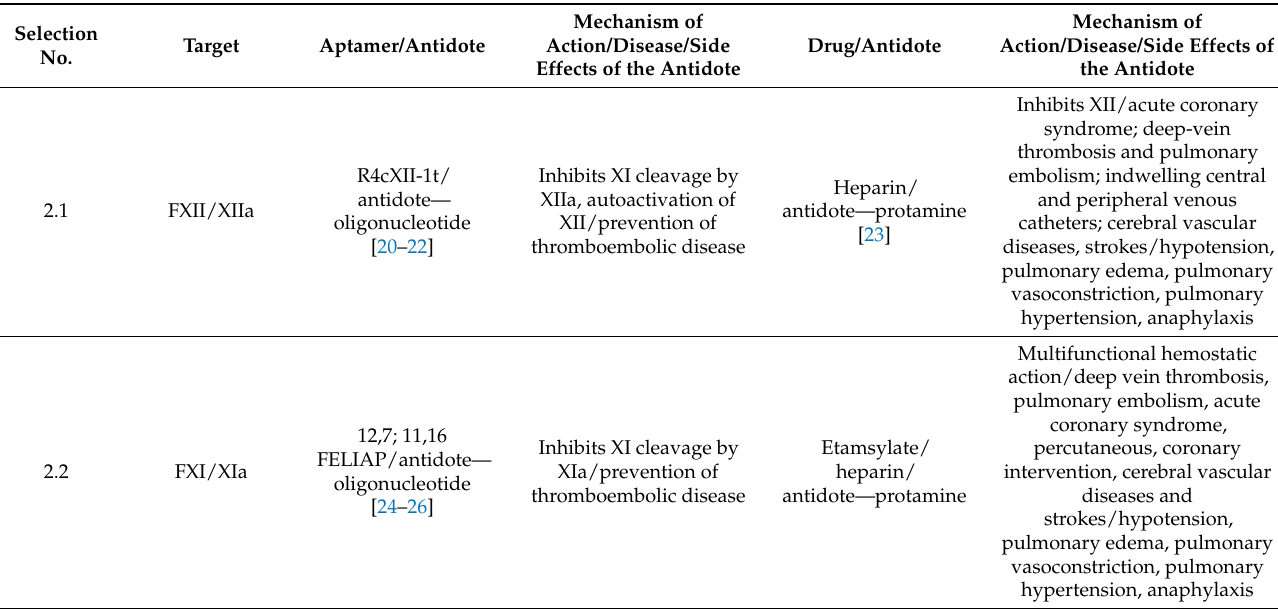
Table 1. Comparative characteristics of aptamers and some drugs that block blood coagulation factors. Selection